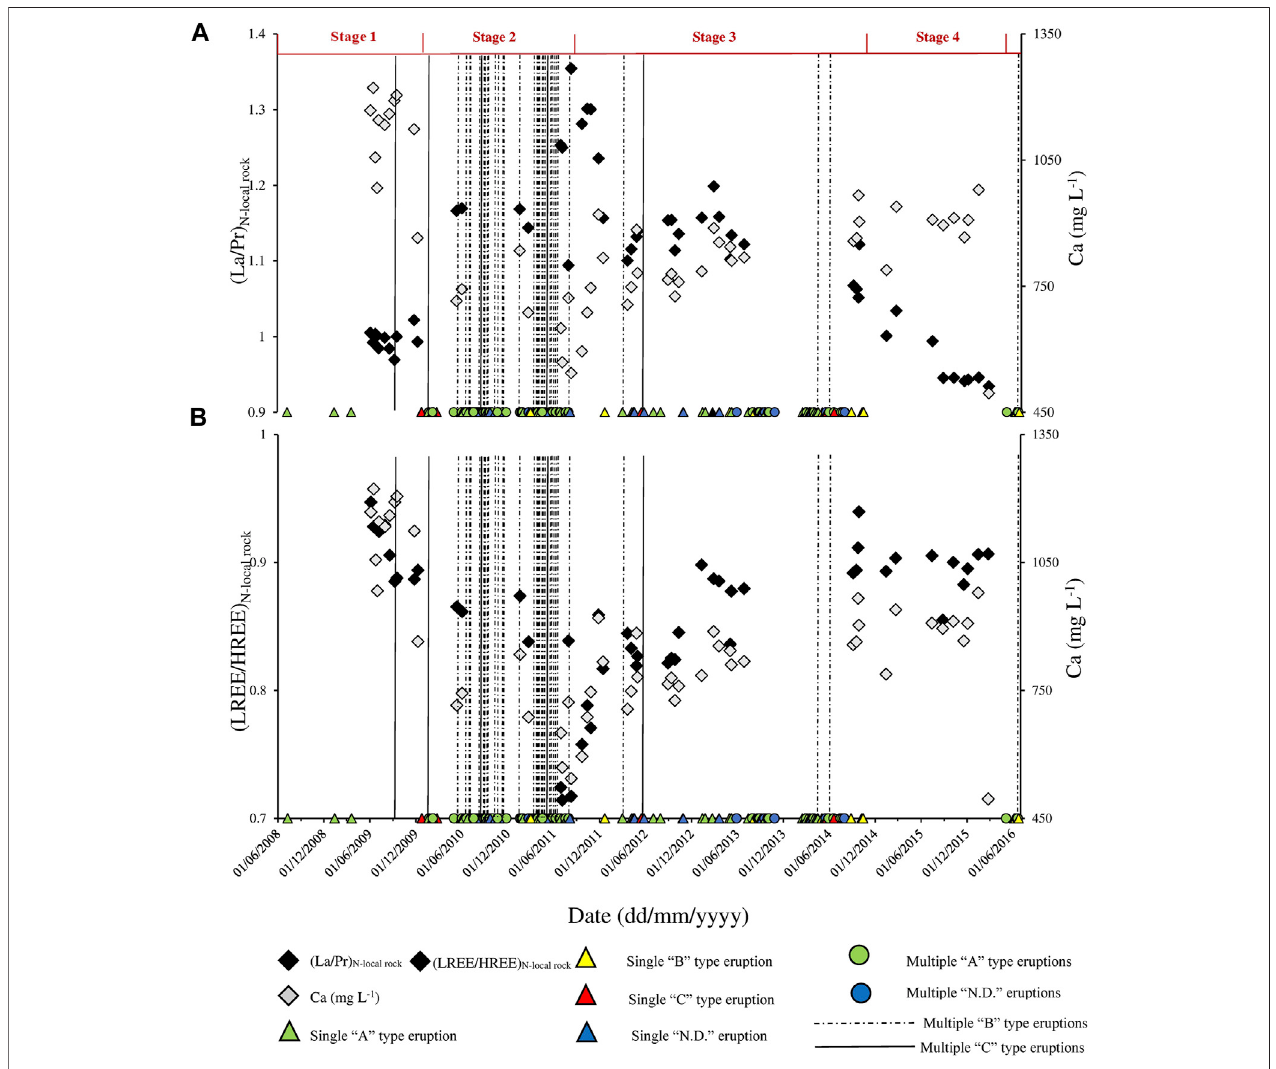
FIGURE 9 | (A) (La/Pr) N-local rock and Ca vs. time. (B) (LREE/HREE) N-local rock and Ca vs. time.